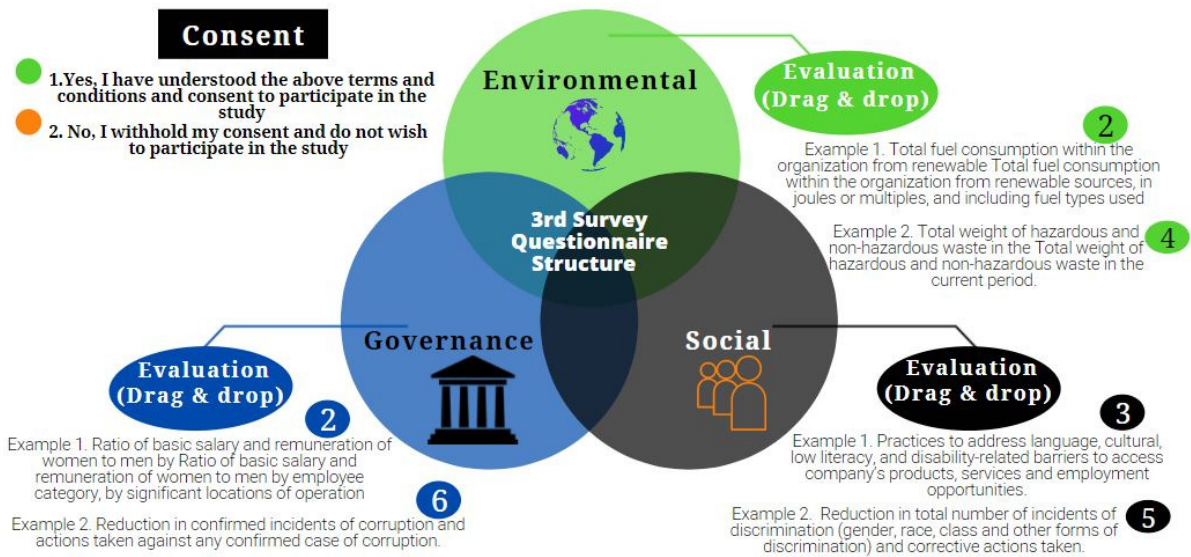
Figure 3. The research instrument used in the 3rd survey. Source: Matemane (2022).